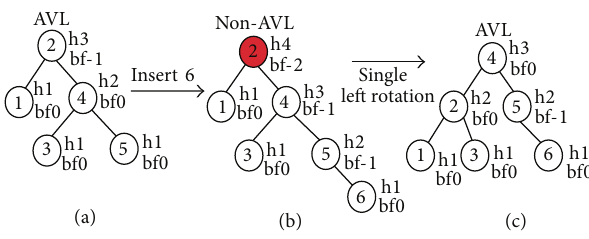
Figure 2: Balancing of AVL tree by a single rotation: (a) insertion of new node, (b) non-AVL tree, and (c) balanced AVL tree after single